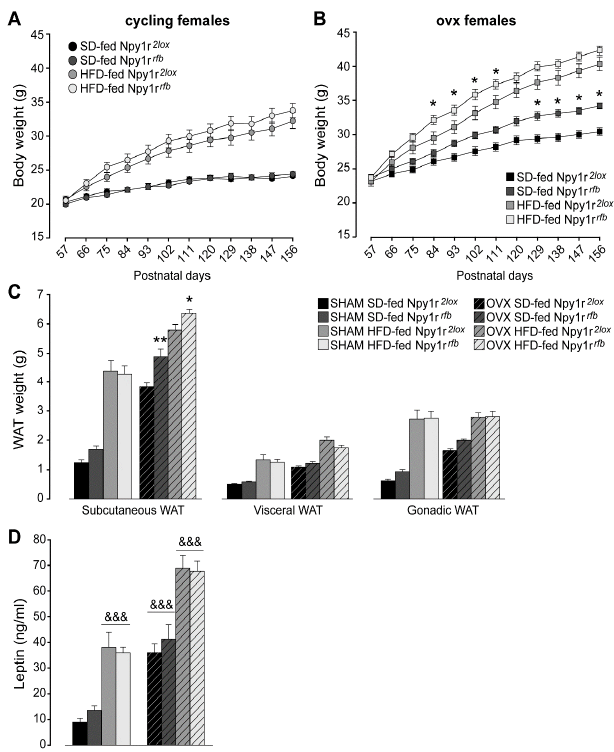
Figure 1. Body weight of standard diet (SD)- and high-fat diet (HFD)-fed cycling ( A ) and ovx ( B ) Npy1r 2lox control and Npy1r rfb knockout female mice. No significant differences in body weight growth were observed between cycling Npy1r 2lox and Npy1r rfb female mice during postnatal days (P) 57–156, independently of diet regimen. SD- and HFD-fed ovx Npy1r rfb females displayed a significantly greater body weight compared with their control littermates on the same diet regimen. Data are the mean ± SEM; n = 17–26 from 6 litters. * p < 0.05 versus the corresponding control females. ( C ) Adiposity of standard diet (SD)- and high-fat diet (HFD)-fed cycling and ovx Npy1r 2lox control and Npy1r rfb knockout female mice. Significantly larger depots of subcutaneous fat were observed in ovx Npy1r rfb females compared with their control littermates on the same diet regimen. Data are the mean ± SEM; n = 10–15 from 3 litters. ** p < 0.01 and * p < 0.05 versus SD-fed and HFD-fed ovx Npy1r 2lox female mice, respectively. ( D ) Leptin plasma levels of standard diet (SD)- and high-fat diet (HFD)-fed cycling and ovx Npy1r 2lox control and Npy1r rfb knockout female mice. Both ovariectomy and HFD increased leptin plasma levels of female mice. Data are the mean ± SEM; n = 10–15 from 3 litters. &&& p < 0.001.